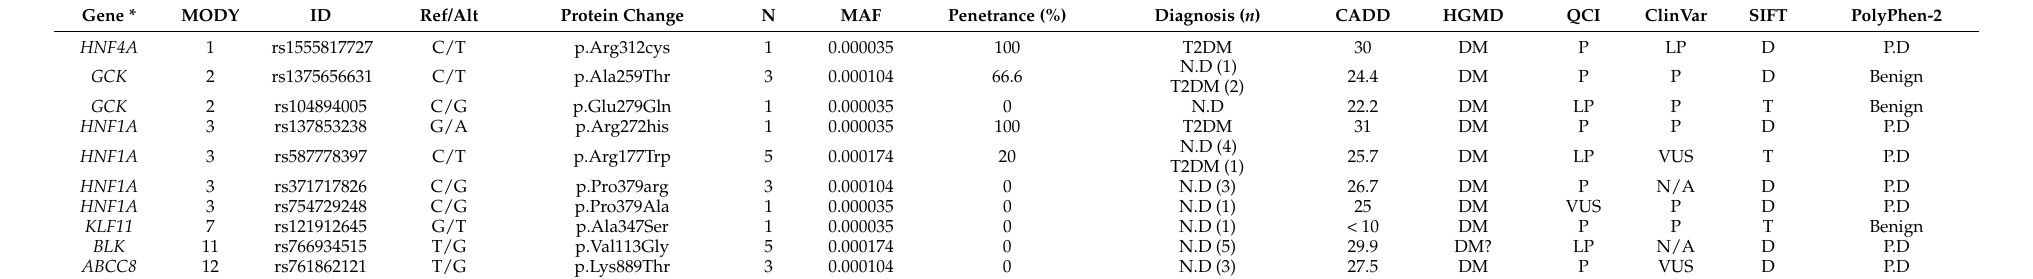
Table 2. Identification of previously reported pathogenic and likely pathogenic MODY-causing mutations.